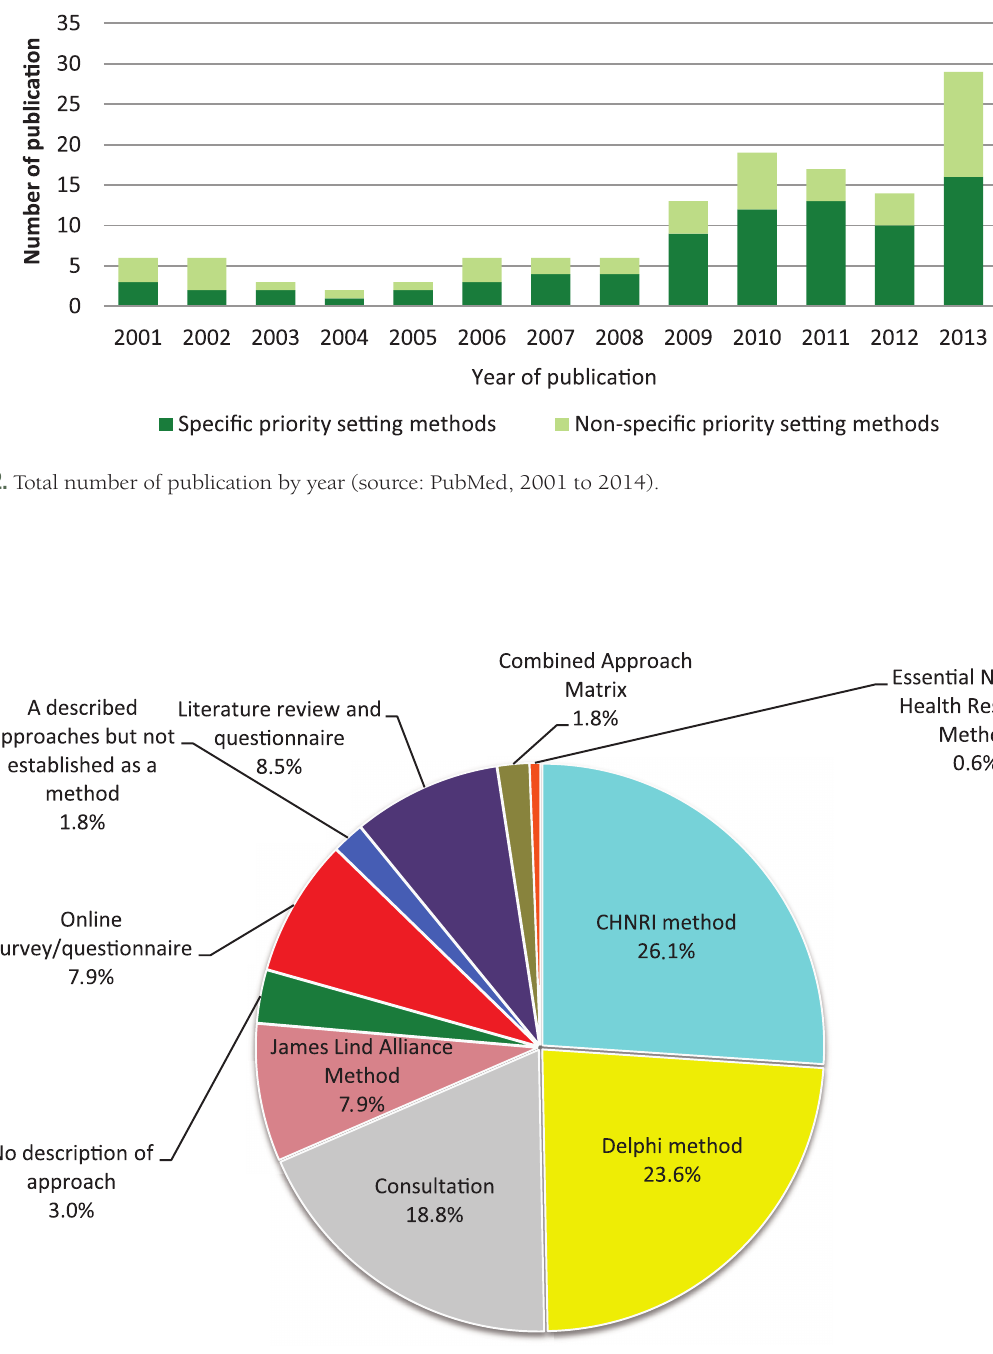
Figure 3. Methods, tools and approaches used for setting health research priorities (source: PubMed, 2001 to